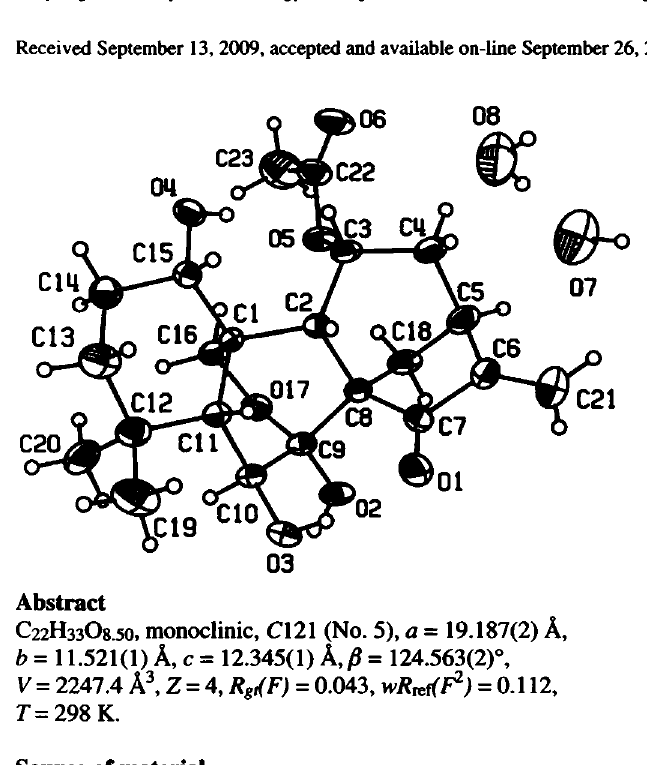
Table 2. Atomic coordinates and displacement parameters (in Â 2